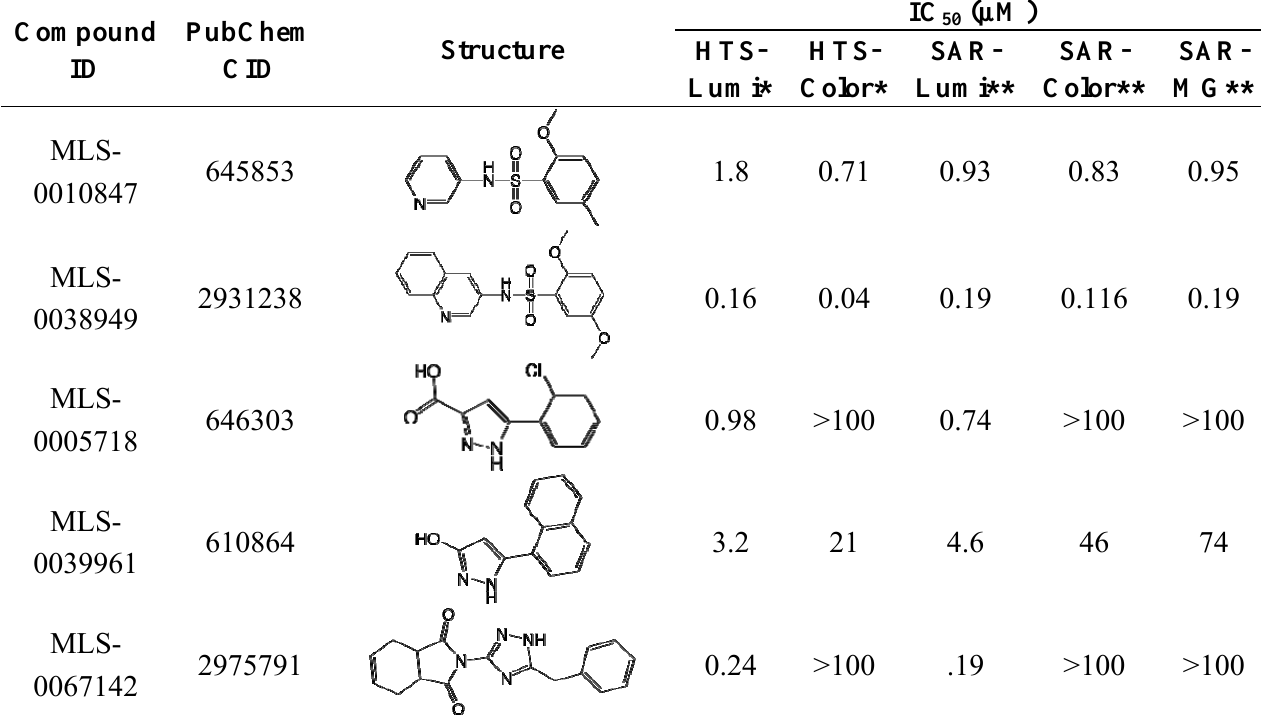
Table 3. Confirmation of Major HTS Scaffolds from Dry